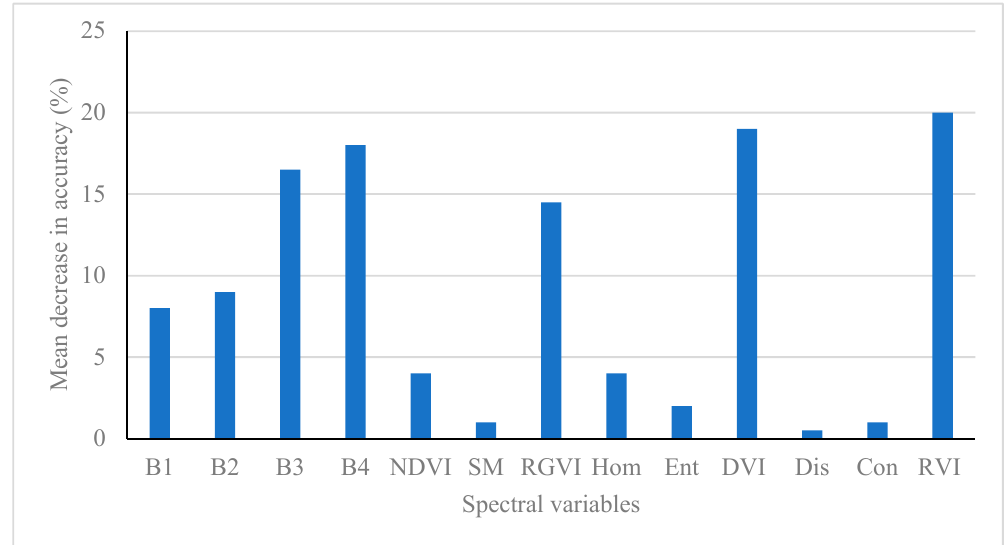
Figure 8. The importance of spectral variables quantified using mean decrease in classification accuracy by random forests (RF).